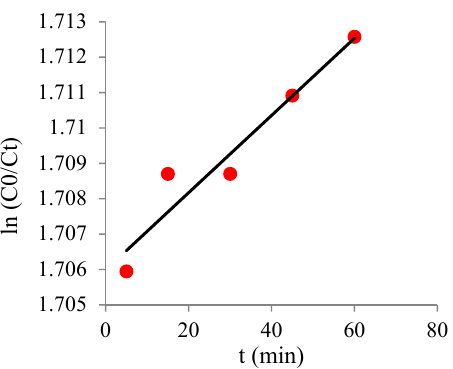
Fig. 15: Pseudo-first-order plot of cadmium adsorption onto polypyrrole/titanium dioxide nanocomposite. Fig.15